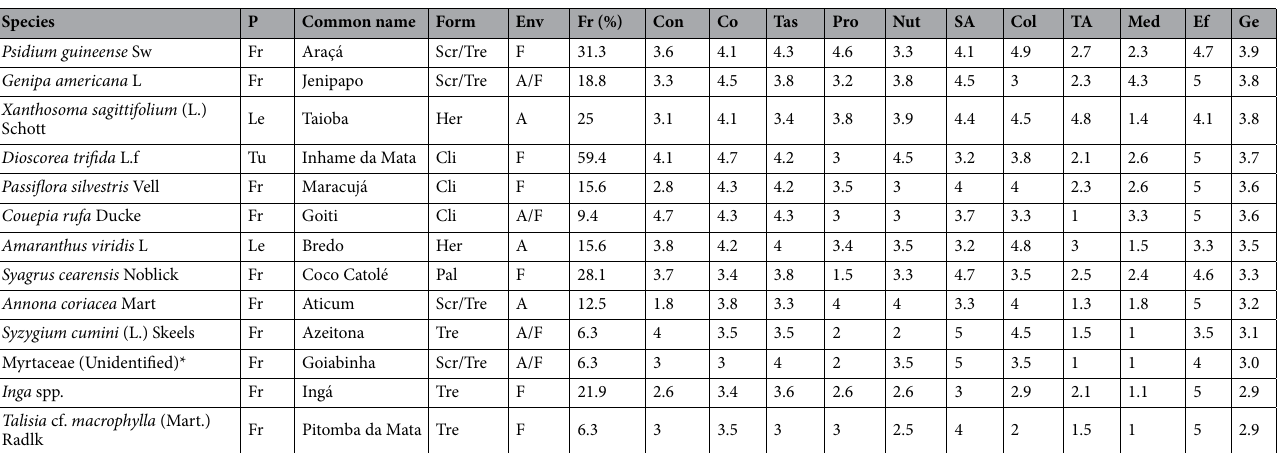
Table 2. Wild food plants cited by more than one respondent in the Dom Helder Câmara community, Murici, Alagoas state, Northeast Brazil. P part used, Form form of life, Env Preferential environment for the species to occur; Fr (%) frequency of citation of the species, Con Average score for consumption intensity, Co Average score for commercial potential, Tas average score for taste, Pro average score for easy propagation, Nut average score for nutritional potential, SA average score for spatial availability of the part used as food, Col average score for ease of collection, TA average score for temporal availability of the part used for food, Med medicinal potential, Ef absence of adverse effects, Fr fruit, Le leaf, Tu tuber, Cli Climbing vine, Scr scrub, Tre tree, Her herb, Pal palm, F forest, A Anthropic areas. *Life form established from local indication and field